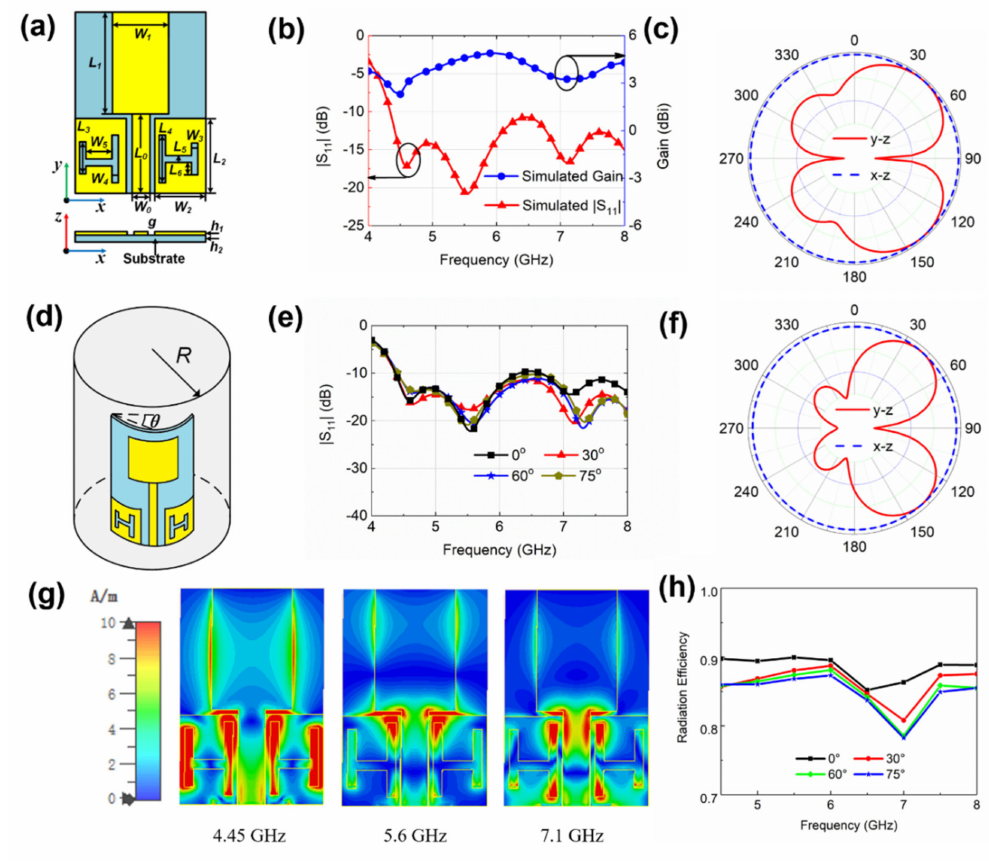
Figure 2. ( a ) Schematic of the GAF antenna. ( b ) Simulation results of return loss (red) and gain (blue) of the GAF antenna. ( c ) The simulated far-field pattern of the antenna at 5.6 GHz. ( d ) Simulation sketch of bending of the antenna in electromagnetic simulation software. ( e ) Simulation results of | S 11 | with di ff erent bending angles. ( f ) The simulated far-field patterns of the antenna with a bending angle of 60 ◦ at 5.6 GHz. ( g ) Current distribution of the antenna at 4.45, 5.6, and 7.1 GHz. ( h ) Simulation results of radiation e ffi ciency with di ff erent bending